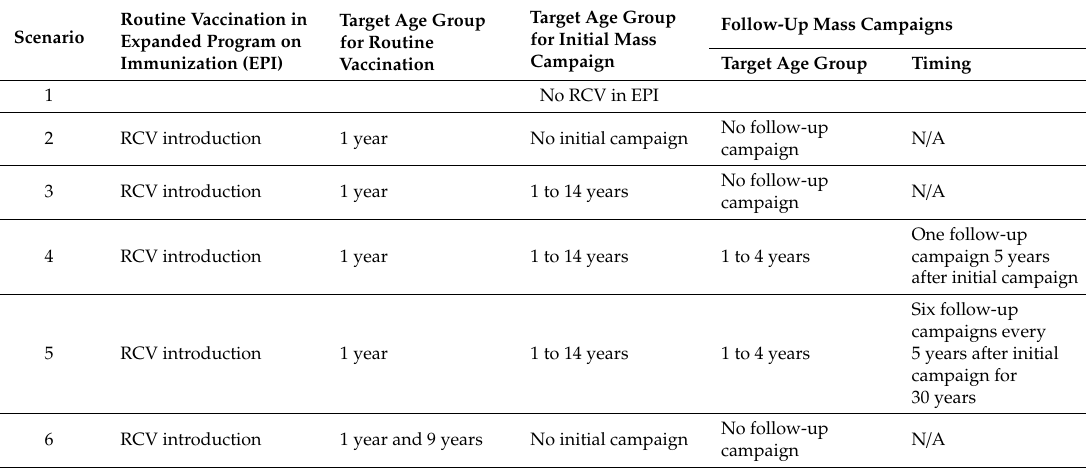
Table 1. Possible scenarios for rubella-containing vaccine (RCV) introduction in South Africa.